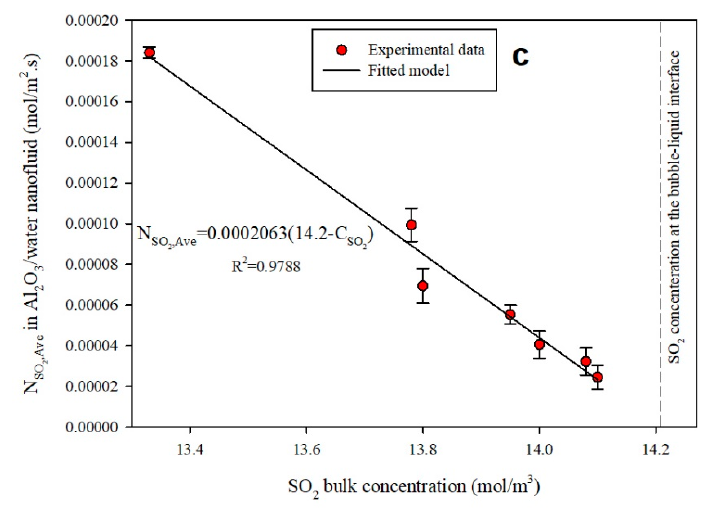
Figure 10. Average molar flux versus SO 2 bulk concentration for ( a ) SiO 2 / water, ( b ) Al 2 O 3 / water and ( c ) Fe 2 O 3 / water nanofluids.